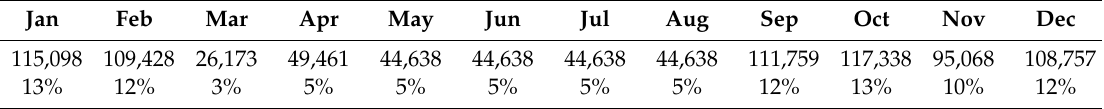
Figure 10. The spatial distribution of the annual nitrate leaching to the Eocene aquifer. Table 6. Monthly amounts of nitrate leaching to the Eocene aquifer